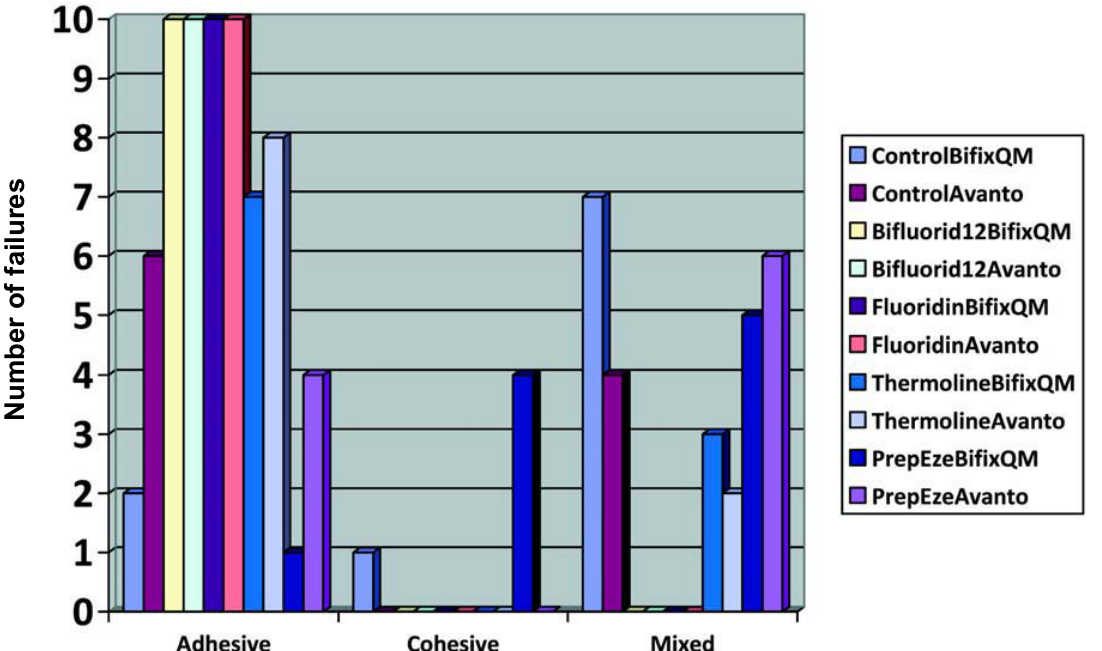
FIGURE 1- Failure modes of the bonding between cements and dentin according to the applied desensitizing agents (n=10)